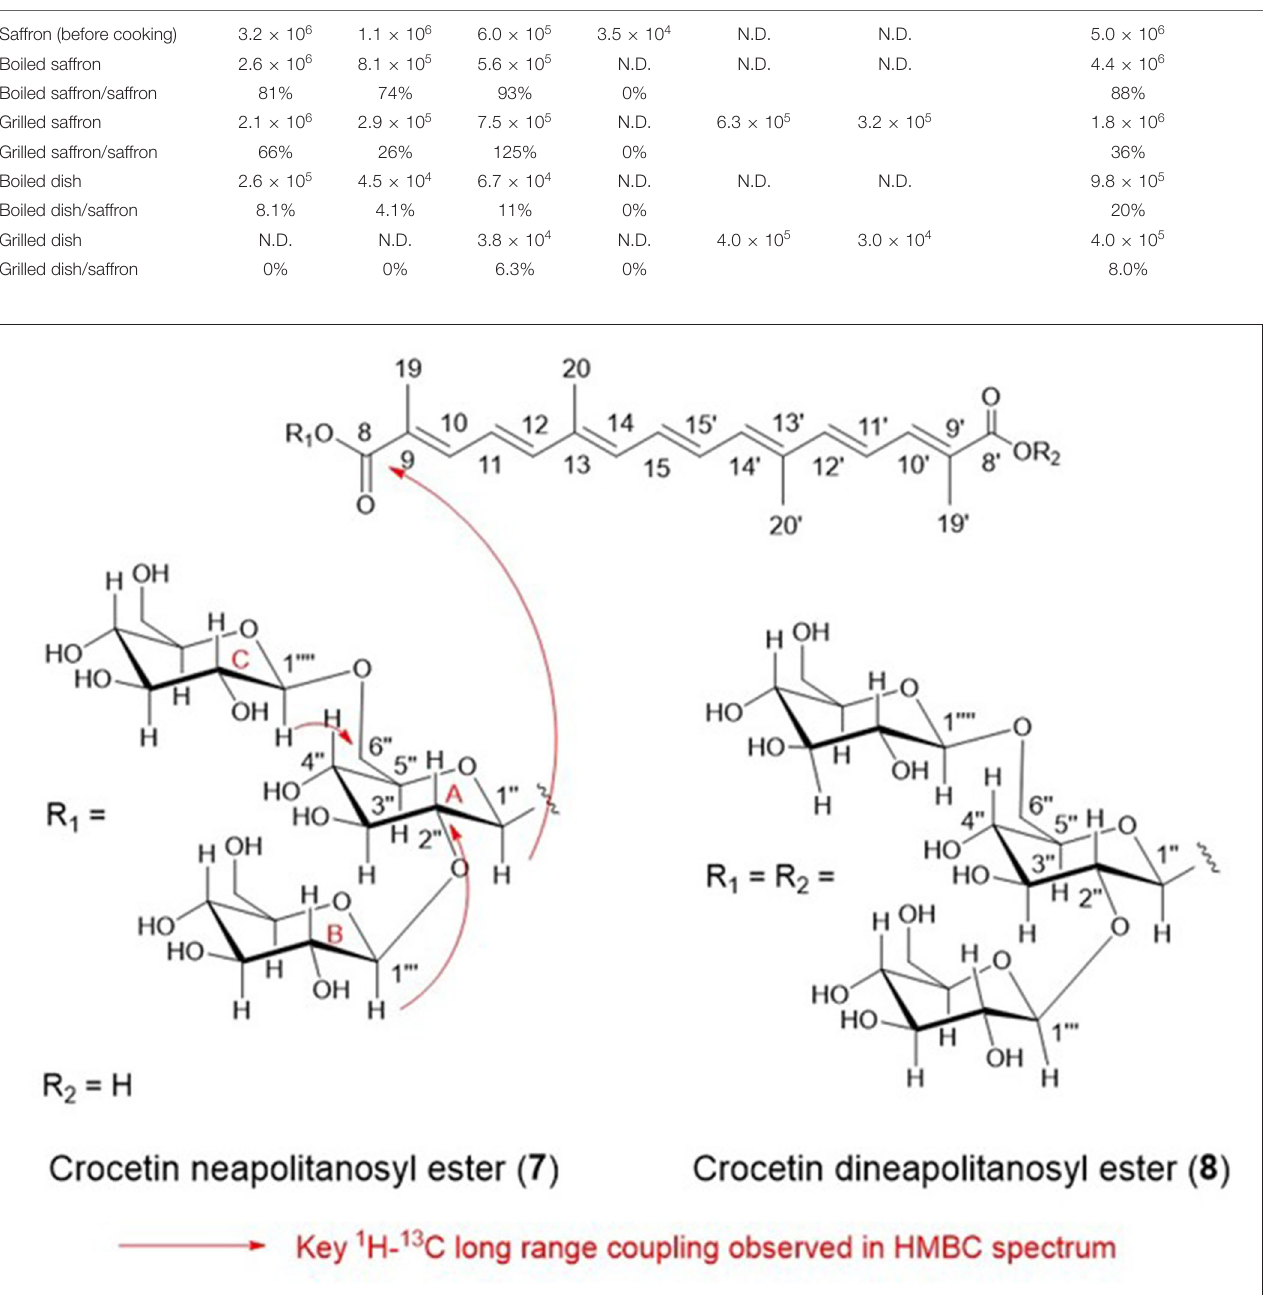
FIGURE 6 | The structures of apocarotenoids in